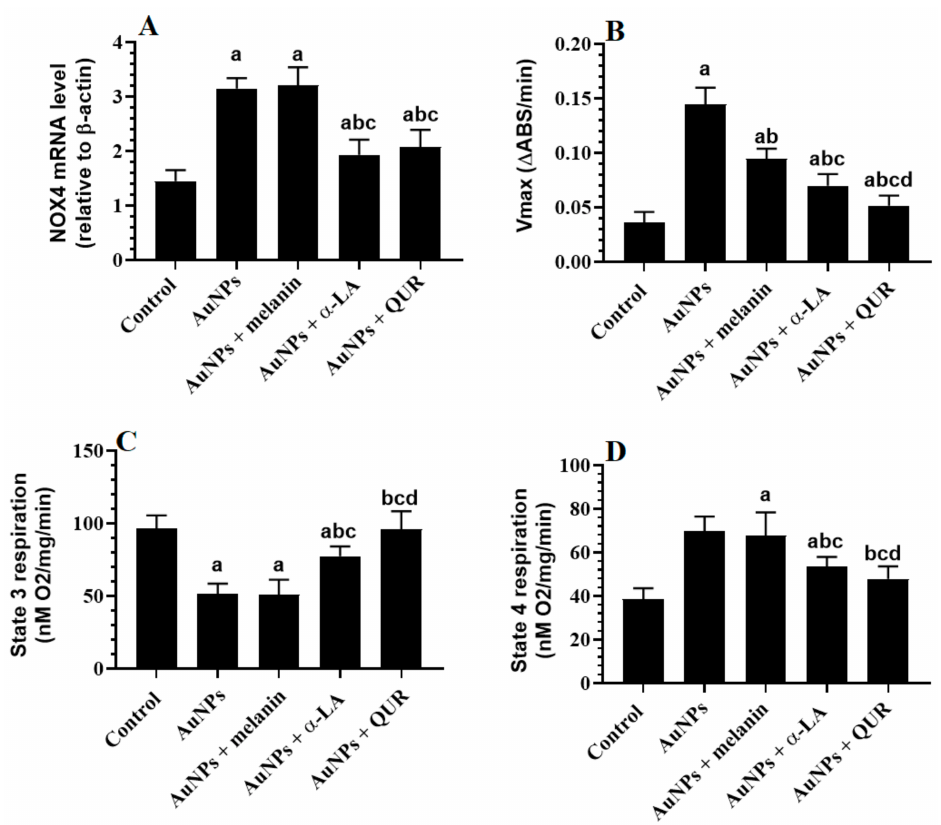
Figure 2. ( A ) mRNA of NOX 4 , ( B ) the reduction in VO 2 max during the assessment of mitochondrial permeability transition pore (mtPTP) opening, and ( C , D ) O 2 consumption during states 3 and 4 mitochondria respiration (mitochondrial coupling) in the kidneys of all groups of rats. Data are given as the mean ± SD ( n = 8 animals/group)— a : vs. control rats; b : vs. AuNPs-treated rats; c : vs. AuNPs + melanin-treated rats; d : vs. AuNPs + α -LA-treated